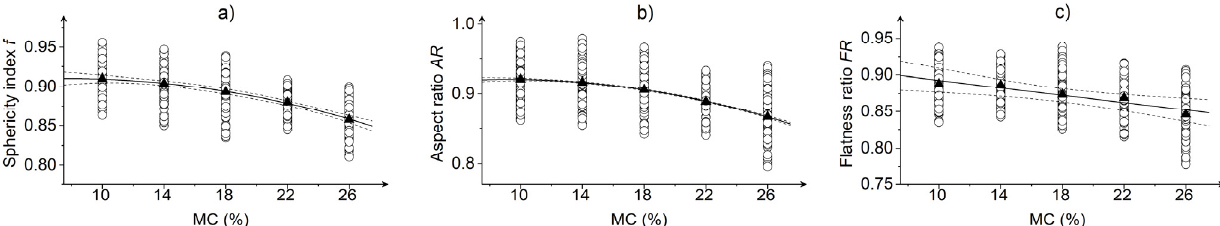
Figure 7. The relationship between moisture content and selected shape characteristics for rice: ( a ) sphericity, f = − 0.000021 MC + 0.515, R 2 = 0.999, ( b ) aspect ratio, AR = − 0.00058 MC + 0.483, R 2 = 0.887, ( c ) flatness ratio, FR = 0.00147 MC + 0.632, R 2 = 0.945; ○ —data, ▲ —mean, ─ —fitted curve, -- --—95% confidence band.